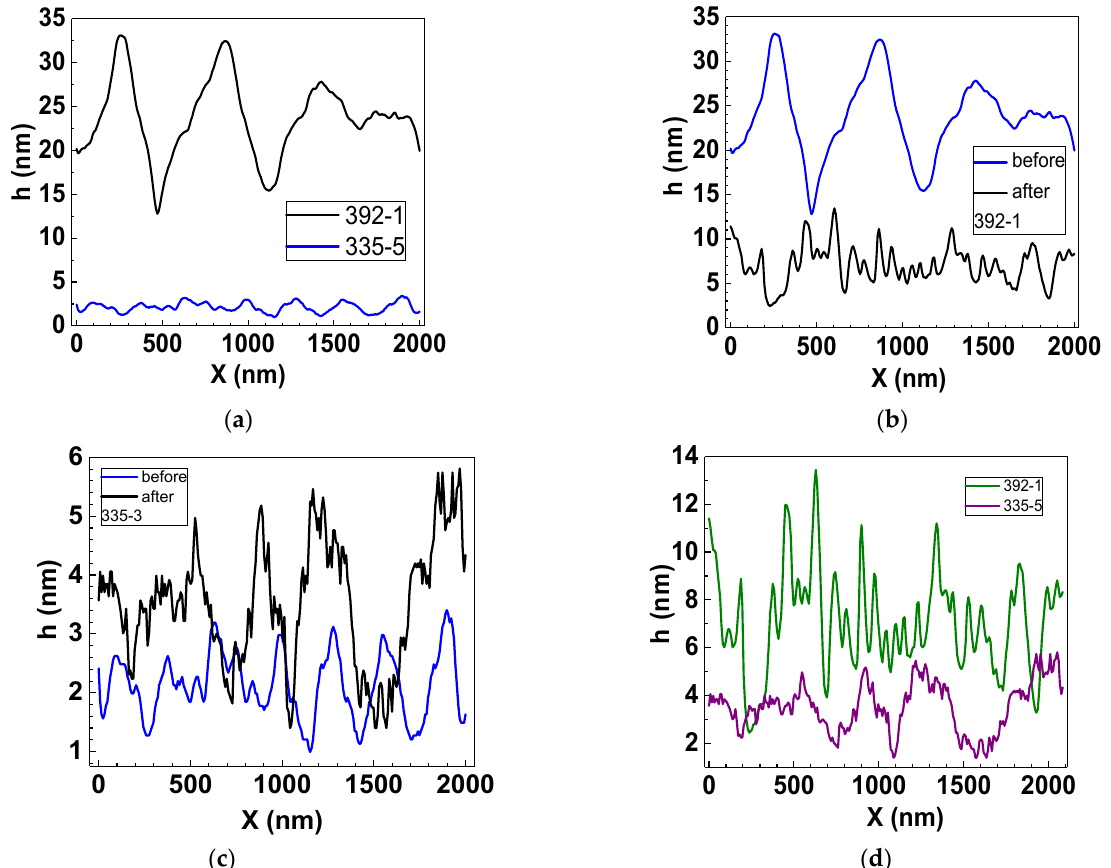
Figure 8. AFM surface profiles of chips before and after functionalization. ( a ) Group 1 and 2 chips before functionalization (pristine graphene in the chips). ( b ) A Group 1 chip before and after functionalization. ( c ) A Group 2 chip before and after functionalization. ( d ) Group 1 and 2 chips after functionalization.